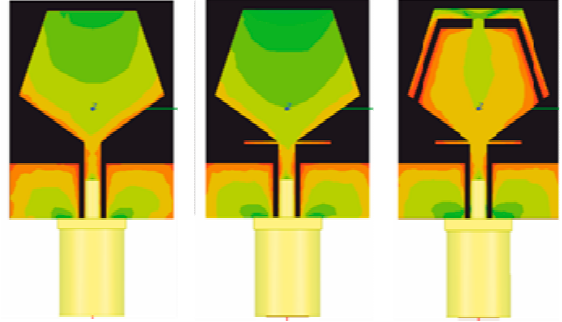
Figure 3. The current distribution of the antenna at various design steps.